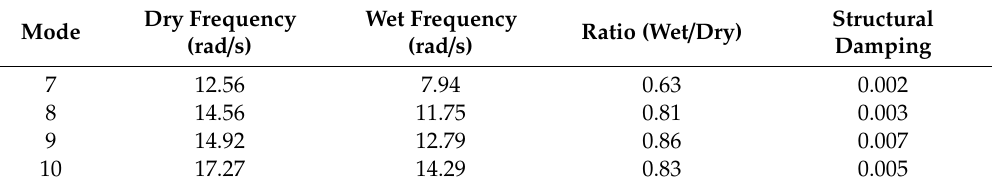
Table 4. Dry and wet resonance characteristics.